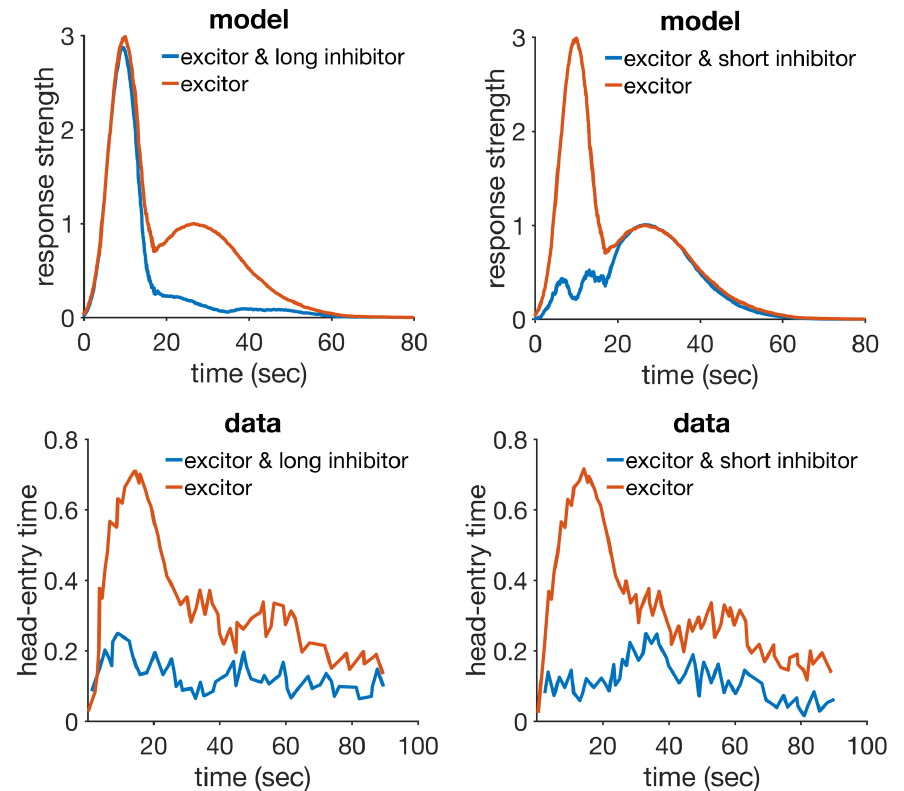
Fig 9. Conditioned inhibition. Left column:simulation(top) and data (bottom) from conditionedinhibition with a long inhibitor.Right column: simulation(top) and data (bottom) from conditionedinhibition with a short inhibitor.Data plots redrawn from Figure 4 in [92]. Model parameters: α t = 0.09, α V = 0.06, μ = 1, σ = 0.35, m = 0.16, H =